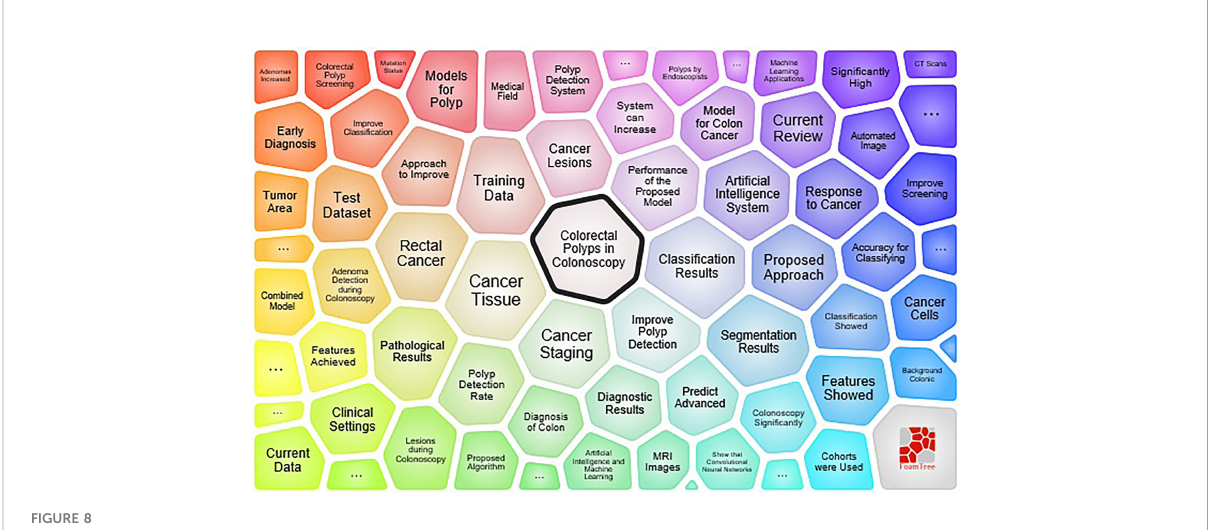
FIGURE 8 major topic survey based on the carrot